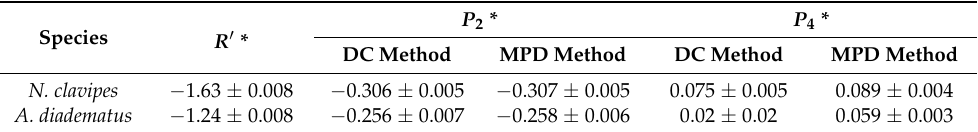
Table 1. Qualitative parameter R ′ = 1 − ( I XX / I ZZ ) and order parameters P 2 and P 4 of Nephila clavipes and Araneus diadematus major ampullate (MA) silk fibers as estimated from the polarized amide I bands and evaluated according to the depolarization constant (DC) and most probable distribution (MPD) methods.